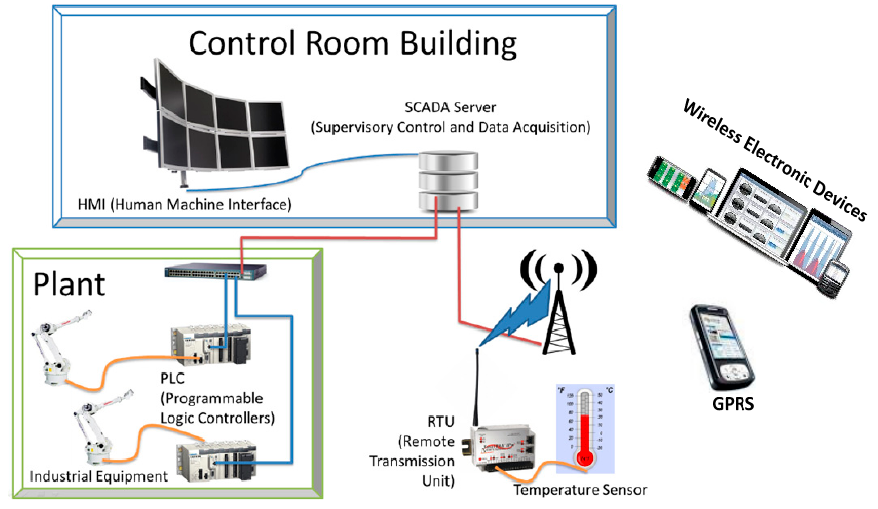
Figure 1. SCADA system and network components.